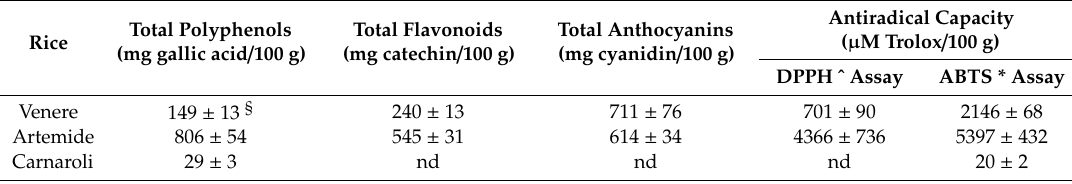
Table 2. Total polyphenols, total flavonoids, total anthocyanins and antiradical capacity of a serving (100 g) of rice (Artemide, Venere and Carnaroli) after cooking in rice cooker for 25 min, including the cooking water (estimated according to Fracassetti et al., 2020